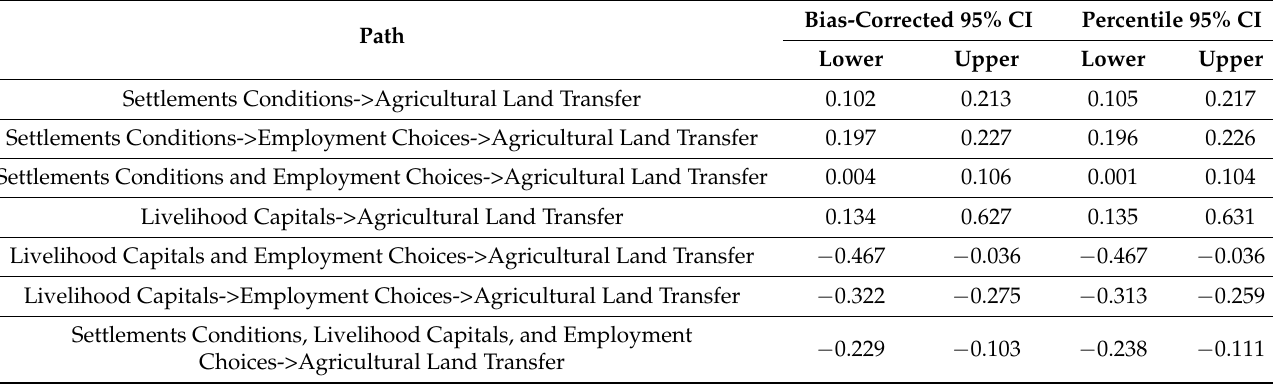
Table A4. Confirmatory factor analysis (CFA) of the discriminant validity.